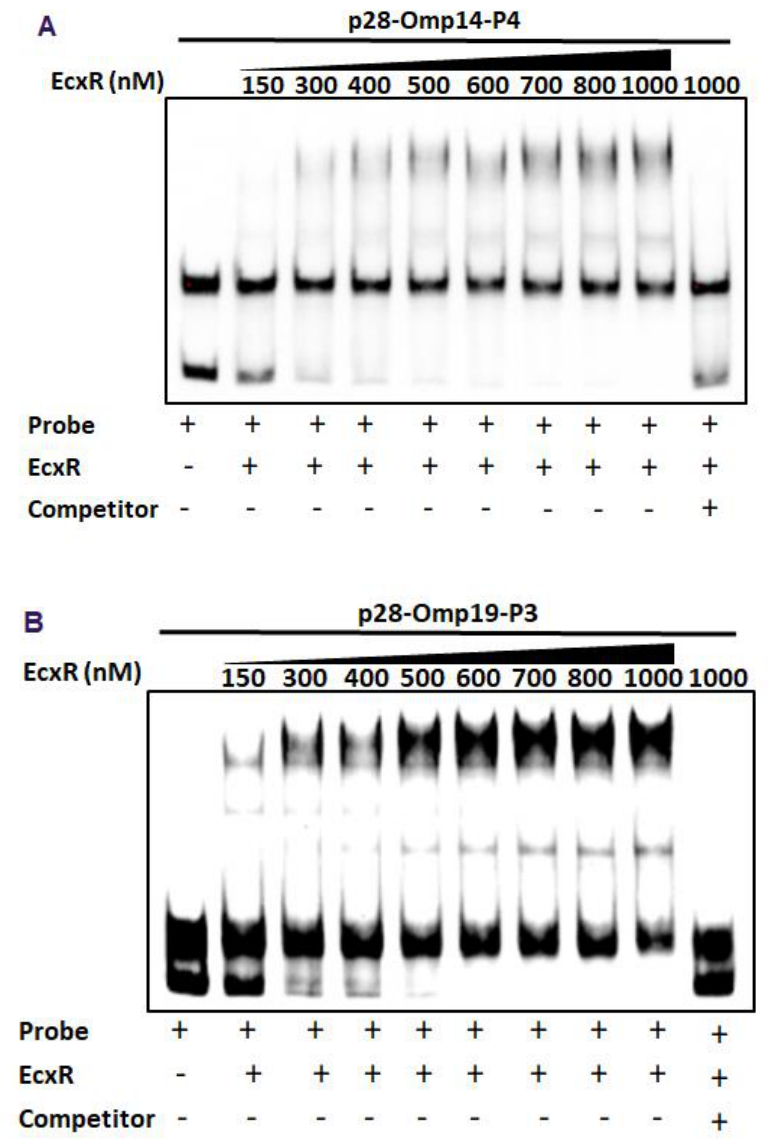
Figure 4. EMSAs to determine binding affinities of two promoter segments. The assays were performed using the biotin-labeled DNA probe of p28-Omp14-P4 ( A ) or p28-Omp19-P3 ( B ) incubated with various concentrations of EcxR. DNA probes and EcxR were incubated at room temperature for 20 min before electrophoresis. Samples were run on 5% polyacrylamide-Tris-borate-EDTA (TBE) gel. The amounts of EcxR used in each reaction are indicated at the top of images.